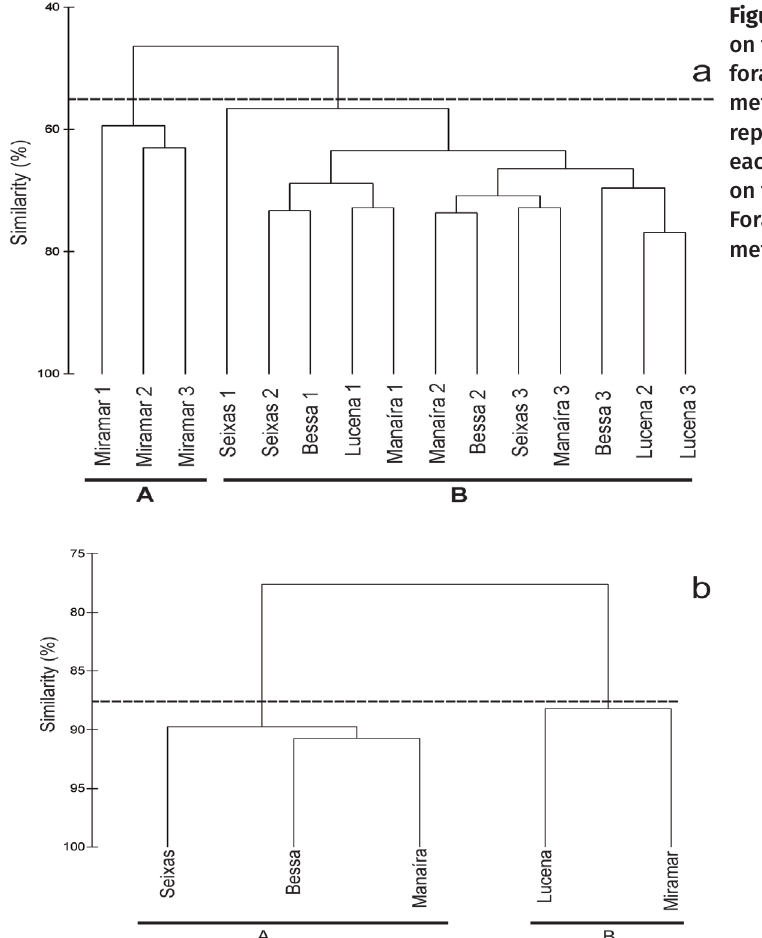
Figure 5. Cluster analysis (a) based on taxonomic composition of dead foraminiferans from João Pessoa metropolitan area, each number represent one replicate sample of each sampling site, and (b) based on taphonomic composition of Foraminifera from João Pessoa metropolitan